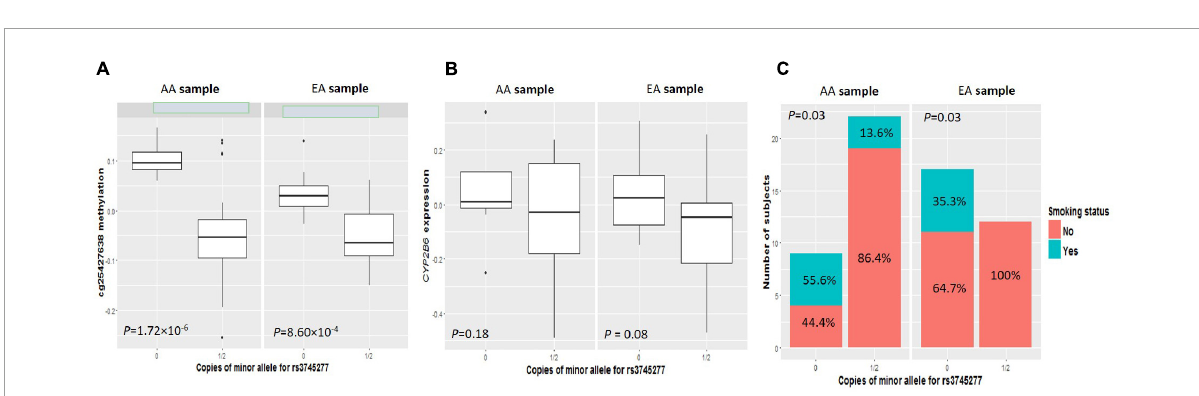
FIGURE2 Comparisons of cg25427638 methylation, CYP2B6 expression, and smoker percentage between subjects with zero copies of rs3745277 minor allele and those with either one or two copies in AAs or EAs, respectively. The four boxplots indicate methylation at cg25427638 (A) and expression for CYP2B6 (B) for subjects with 0 or 1/2 copies of rs3745277 minor allele (A) in the AA (left) or EA (right) ethnic group. Student’s t -test results are included. The barplots in (C) illustrate smoker and non-smoker percentages for each genotype group in AAs or EAs. Fisher’s exact test was performed to obtain the p -values for this panel. P -values < 0.05 are considered